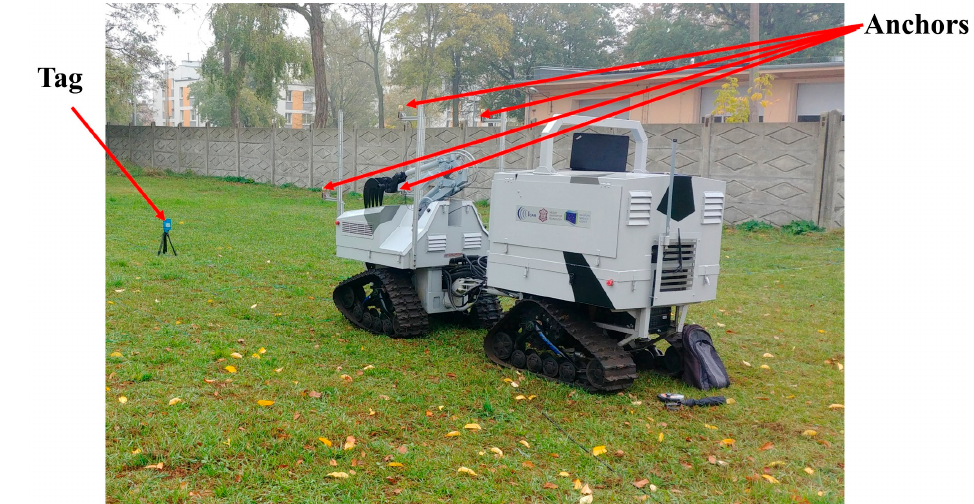
Figure 4. UGV with the location of the anchors and the tag.